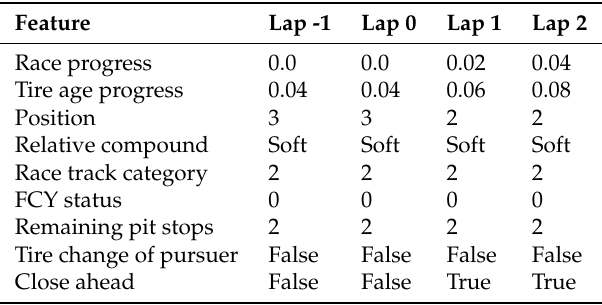
Table 10. Example time series input data for a length of 4laps showing how values before lap 1 are artificially filled with ‘neutral values’.